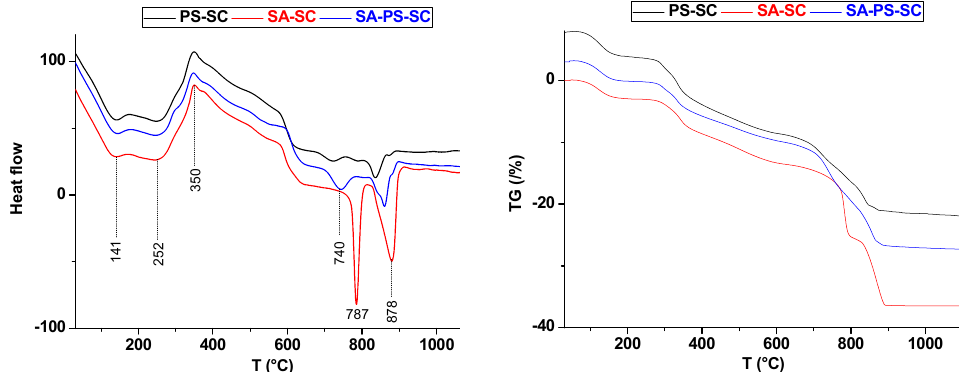
Figure 4. Thermal curves (DTA) and thermogravimetric analysis (TG) of PS-SC, SA-SC and SA-PS-SC.